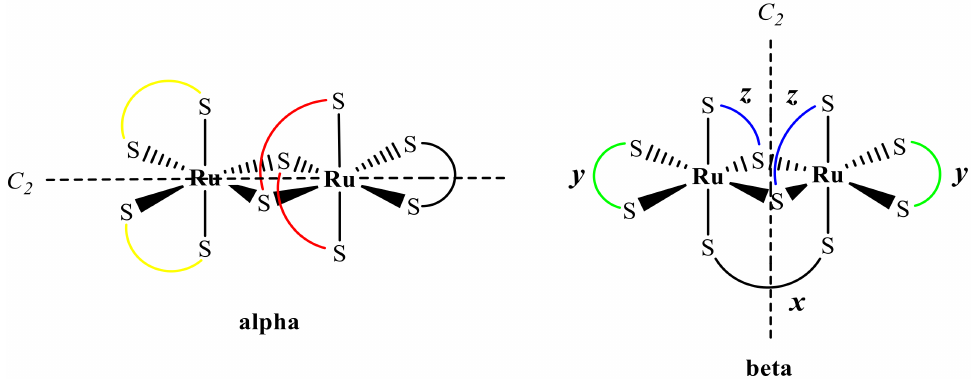
Figure 9. Symmetry equivalent coordinated DMDTs indexed by colour both in the α - and β - configurations (assuming an overall C 2 symmetry. The colour scheme refers to the discussion in the main